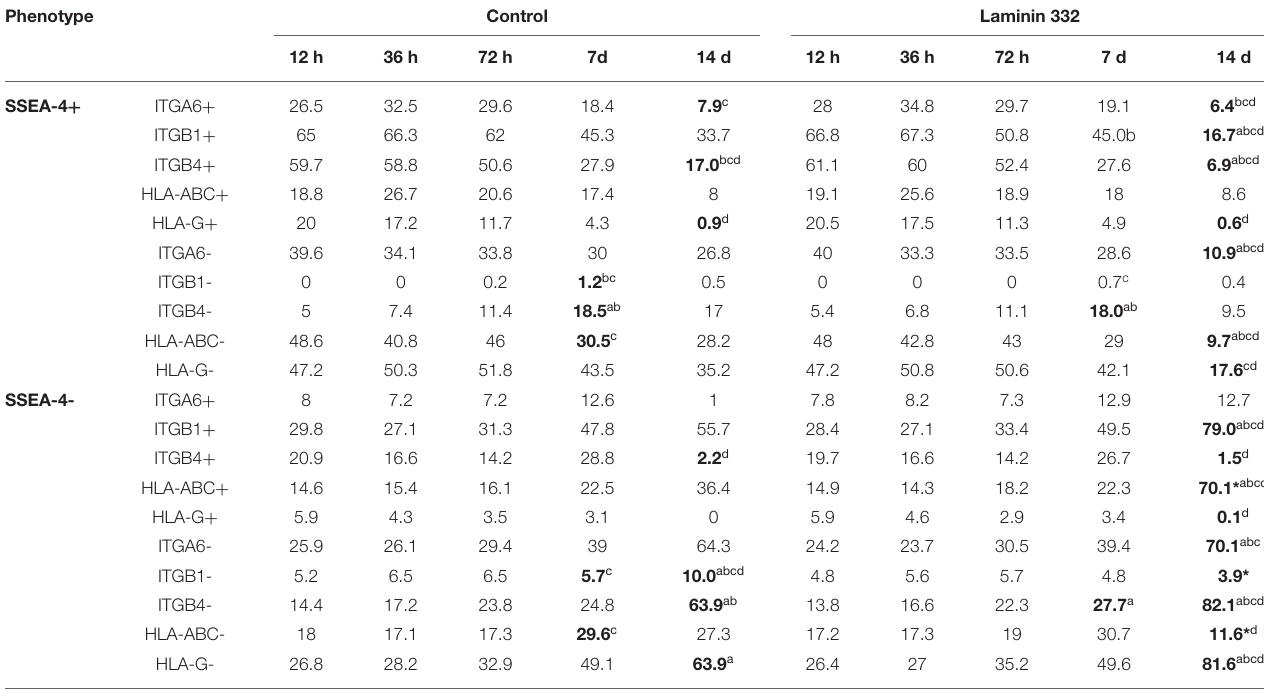
TABLE 3 | Percentage of hAC exhibiting co-expression of pluripotency marker SSEA-4 with integrins or HLA antigens among amnion cells cultured on uncoated (Control) and LN332-coated plates.